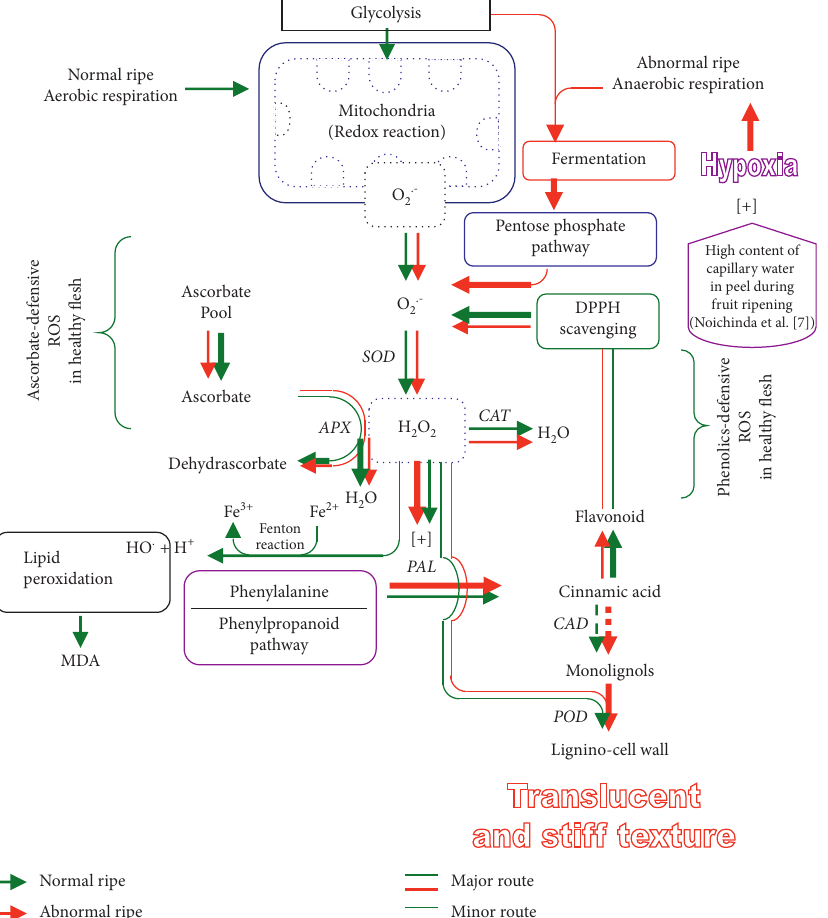
Figure 5: Putative pathways of lignin formation in translucent mangosteen aril related to an increase in phenolics accumulation and the failure of ROS defensive